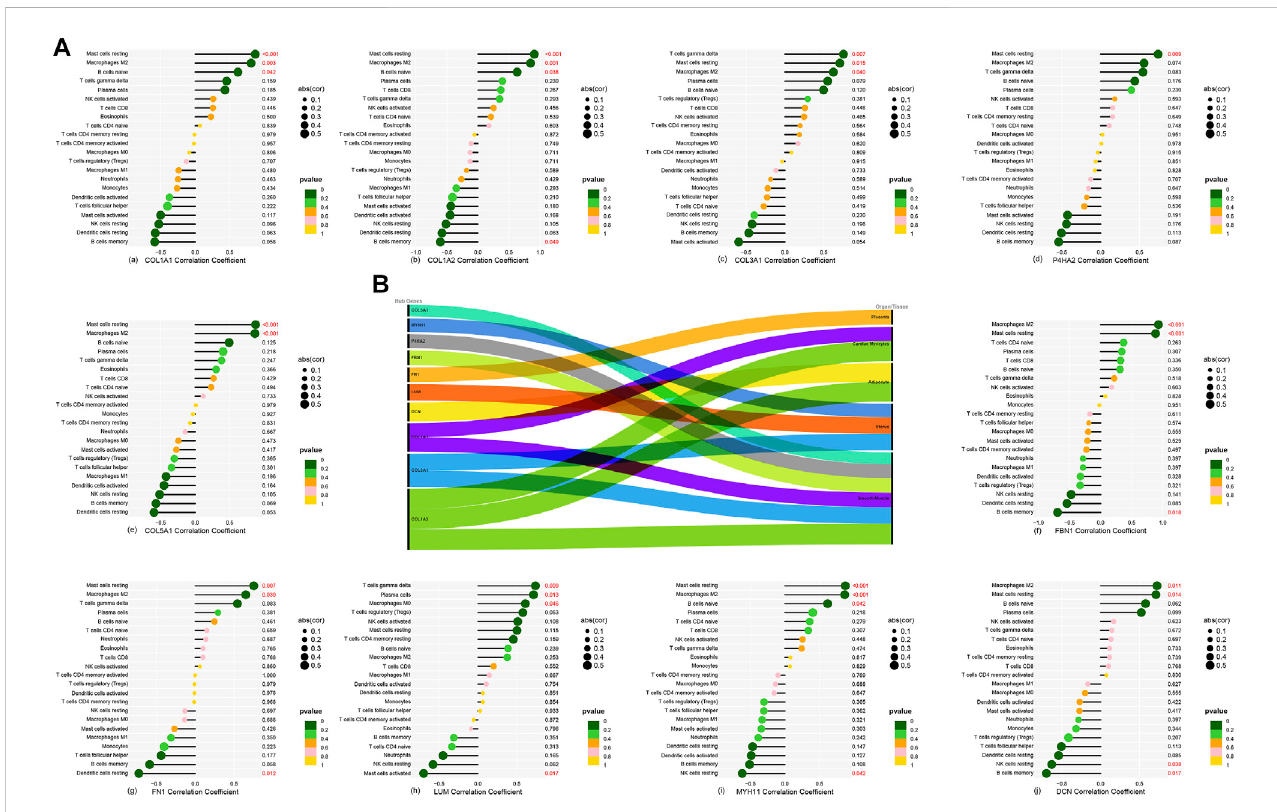
FIGURE 6 (A-a – A-j) Correlation between 10 hub genes and 22 background immune cells. (B) Ten hub genes located in the main expression